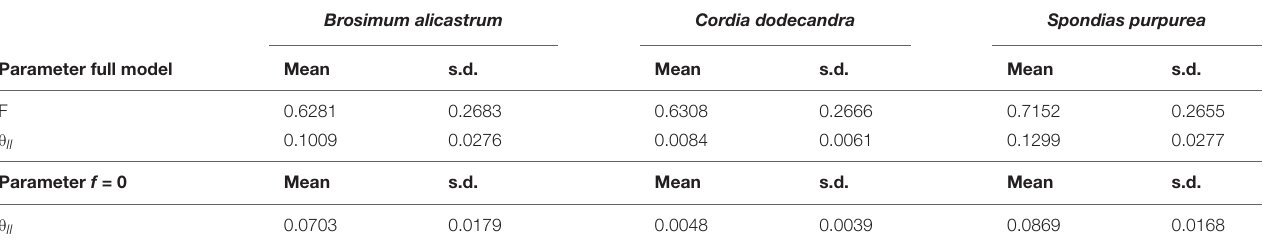
Data estimated from ISSRs markers in three species of multipurpose trees from Yucatan,